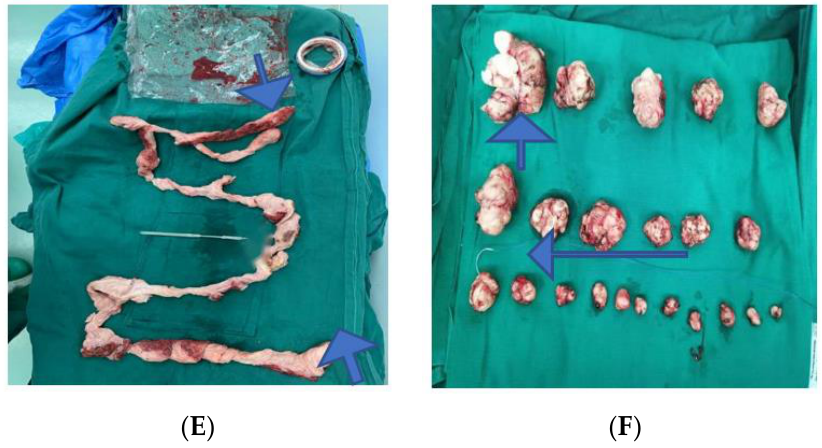
Figure 5. ( A ) The extractor is inserted through an umbilical trocar. ( B ) The fibroids are placed in the specimen bag. ( C ) The incision is dilated with abdominal wall dilator. ( D ) The “peeling” method. ( E ) This is a fibroid removed through the umbilical hole. ( F ) The “bracelet” method. Arrows point to the location and method of fibroids removal and the fibroids removed.